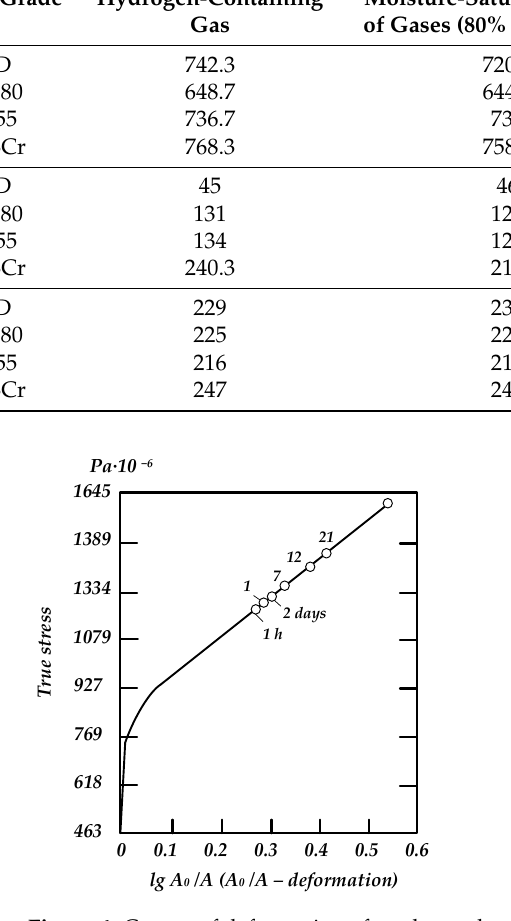
Figure 4. Curves of deformation of steel samples (0.3% C, 3% Cr, 0.4% Mo), held after hydrogenation for various times before testing [26]. The numbers on the curves are the duration of the preliminary exposure of the samples to atmospheric conditions at 293 K.